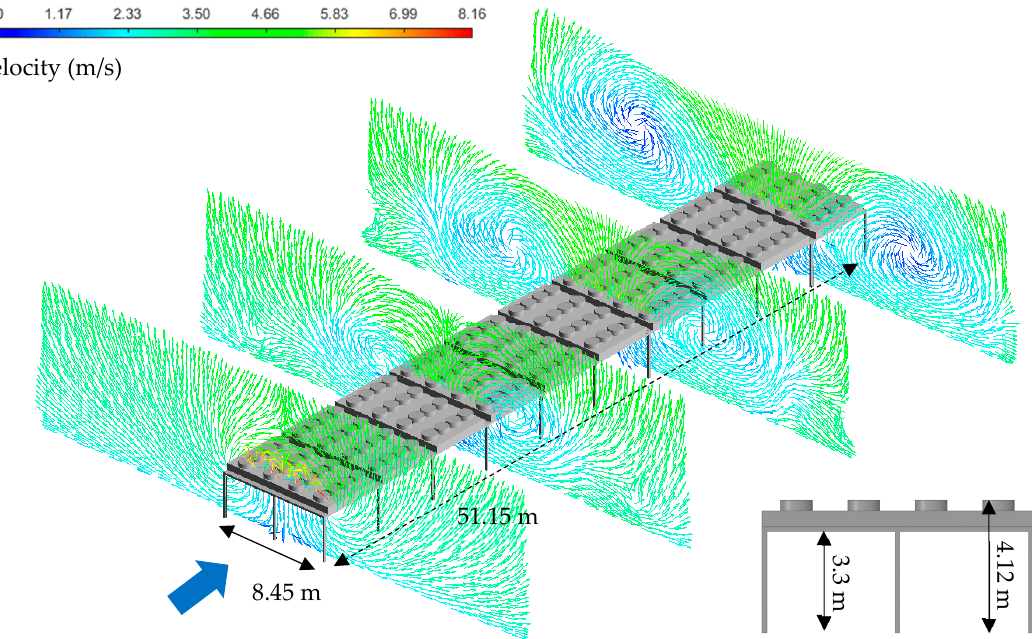
Figure 7. Velocity vectors at different locations of the evaporators, uniform field and south wind condition.